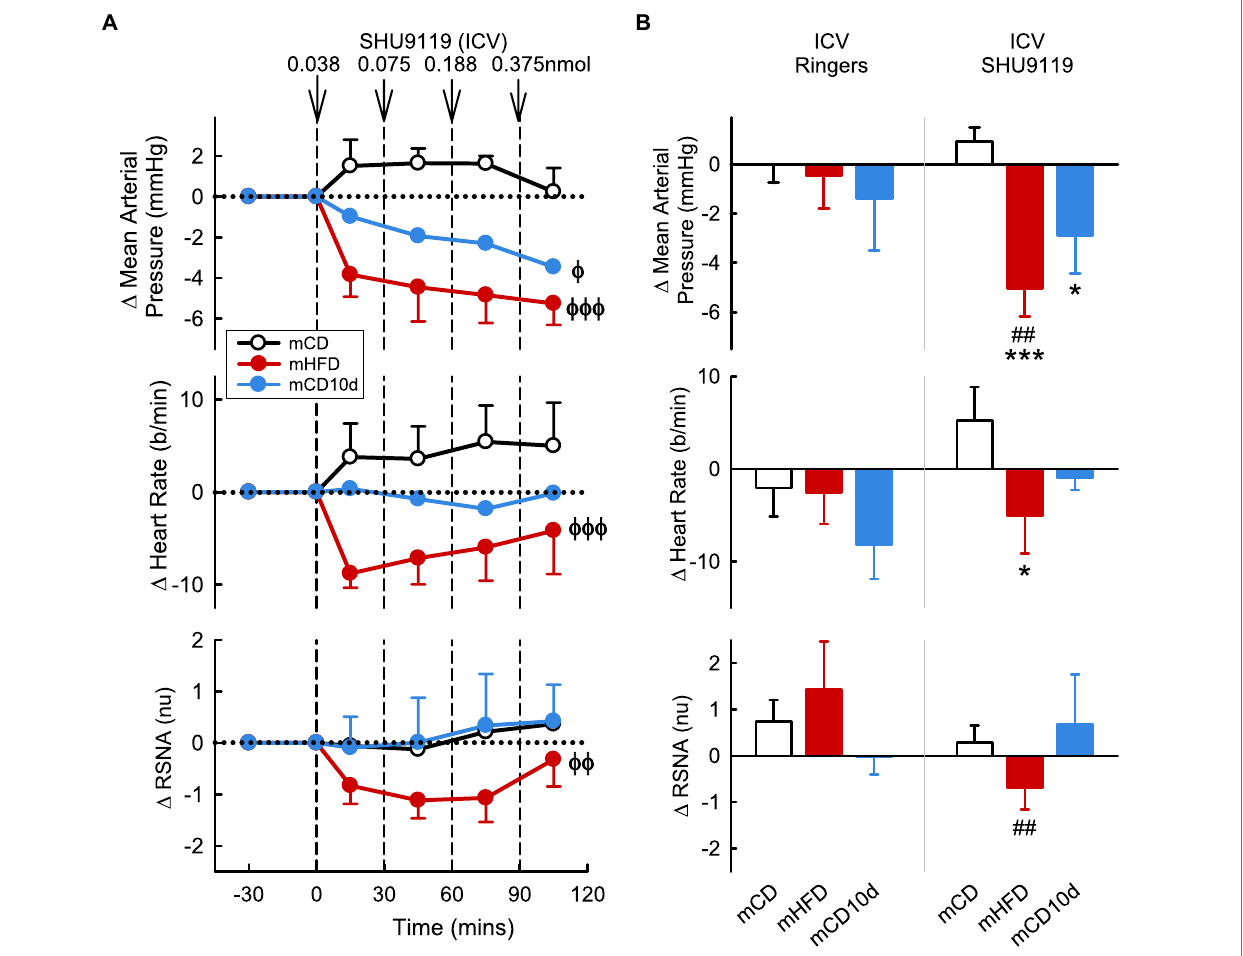
FIGURE 8 | Effects of SHU9119 injected ICV. (A) Average changes in MAP, heart rate, and RSNA (normalized units) from control in each group after ICV administration of SHU9119 (0.038, 0.075, 0.188, and 0.375 nmol, shown at dashed lines) in mCD (white, n = 8), mHFD (red, n = 8), and mCD10d (blue, n = 6) rabbits. Data are mean difference ± SED. ϕ p < 0.05, ϕϕ p < 0.01, ϕϕϕ p < 0.001 for average effect of SHU9119. (B) Changes from control after administration of vehicle Ringer’s and SHU9119, averaged over the last two doses, given ICV in mCD, mHFD, and mCD10d rabbits. Data are mean difference ± SED from the control period of each treatment group. * p < 0.05, *** p < 0.001 for comparison to mCD; ## p < 0.01 for effect of SHU9119 vs.